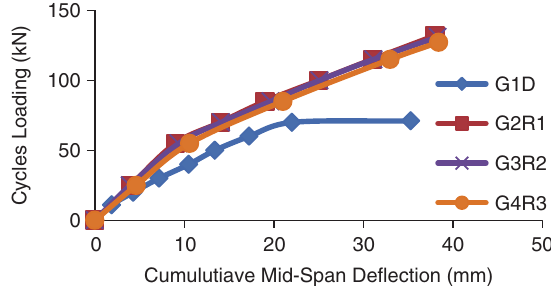
Fig. 6. Load against de fl ection curves for the tested beams